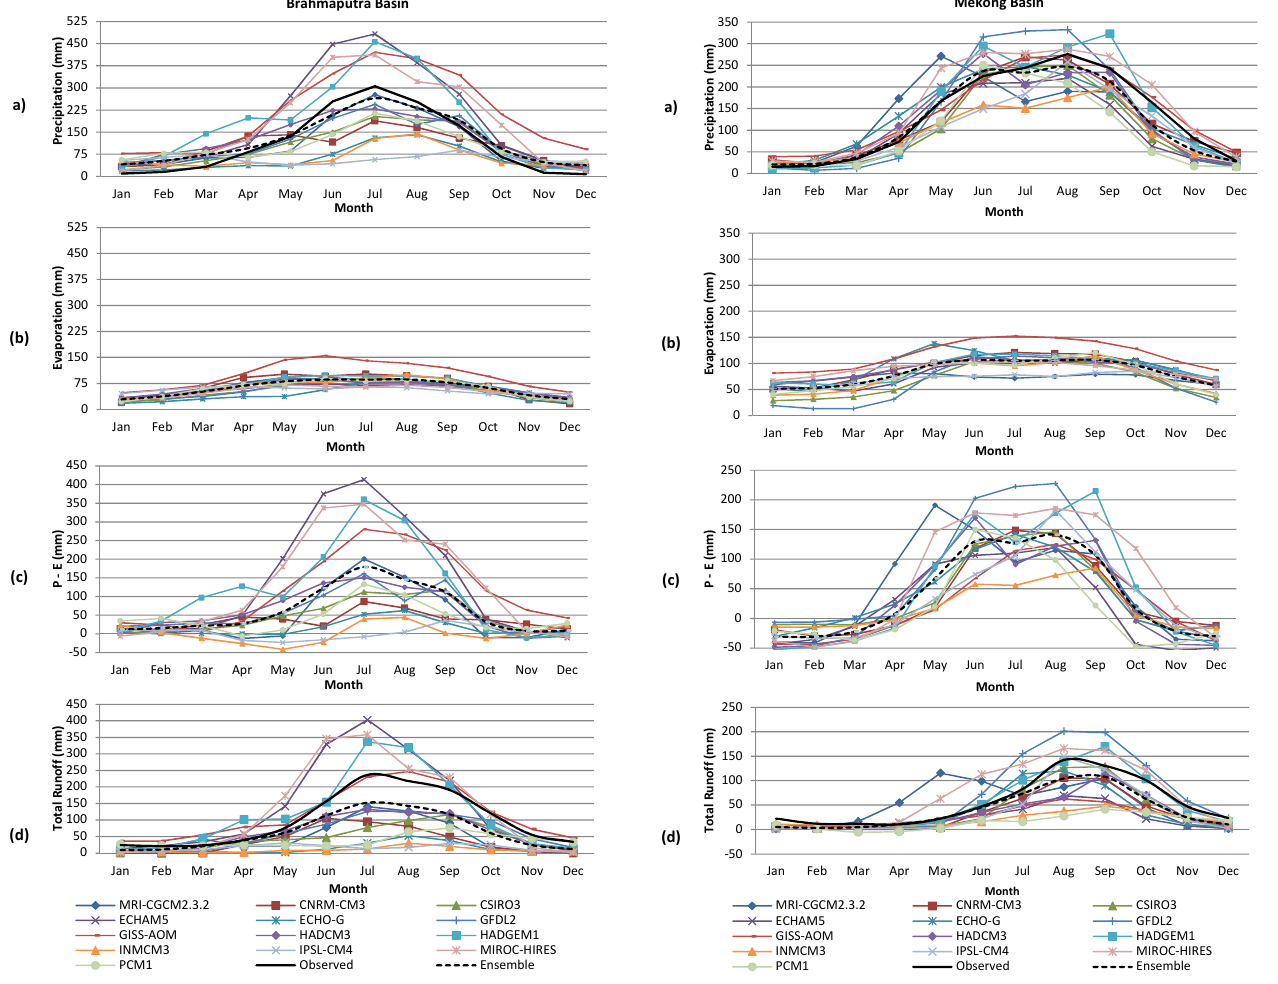
Fig. 5. 20th century annual cycles of considered quantities for the Mekong Basin: (a) P , (b) E , (c) P − E , (d) R